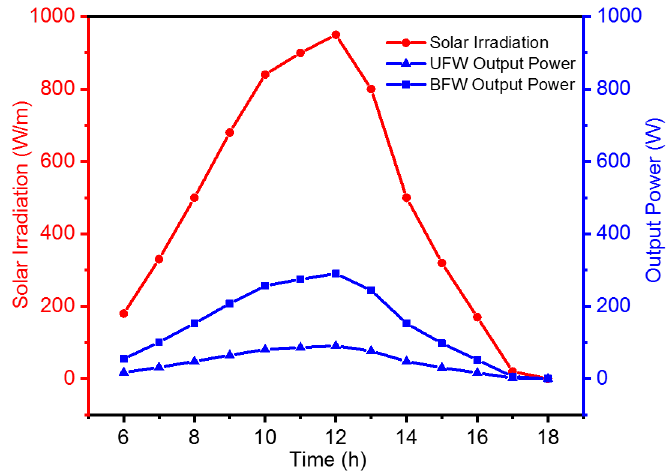
Figure 10. ( a ) The alignment of system along the North–South (N–S) and East–West (E–W) axes; ( b ) Variation of optical e ffi ciency according to angular deviation along the N–S and E–W axes.